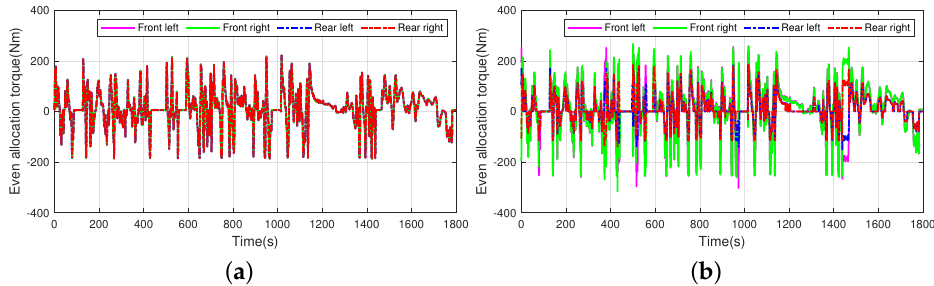
Figure 10. Torque distributions of the even allocation and optimal allocation in WLTC condition. ( a ) Torque distribution with even allocation in WLTC condition. ( b ) Torque distribution with optimal allocation in WLTC condition.